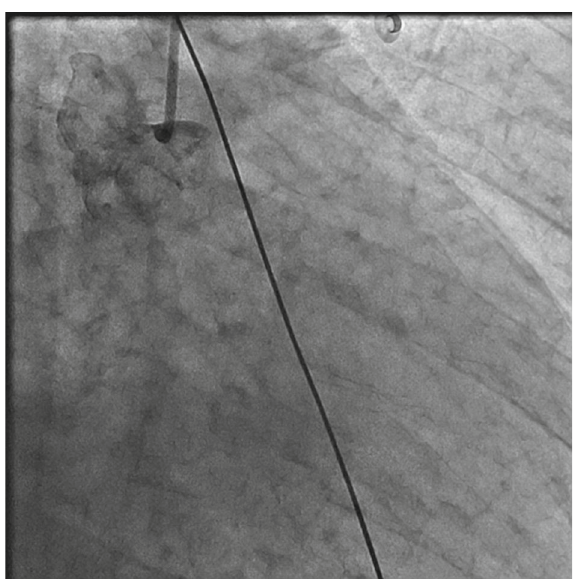
Figure 3: Cardiac catheterization showed total occlusion of